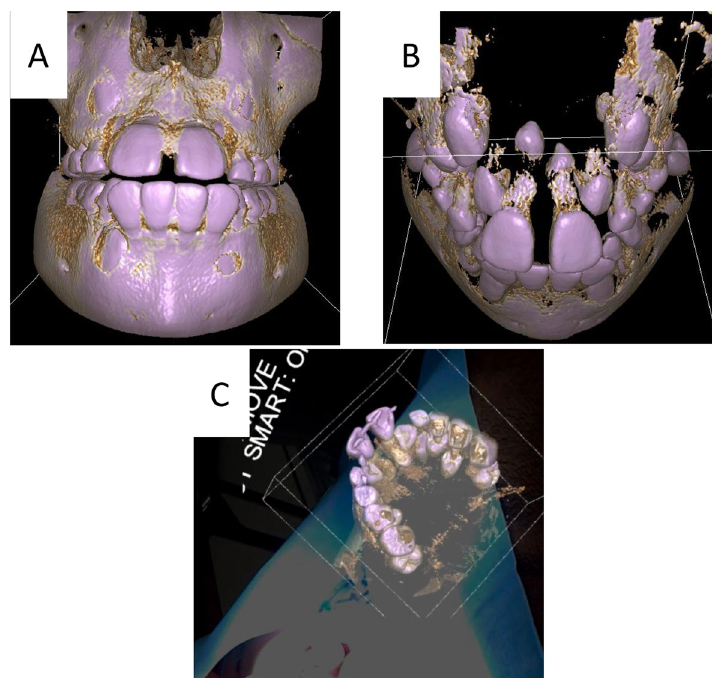
Fig. 3 Case 1. A 3D constructed image. B 3D volume rendering. C Intraoperative view